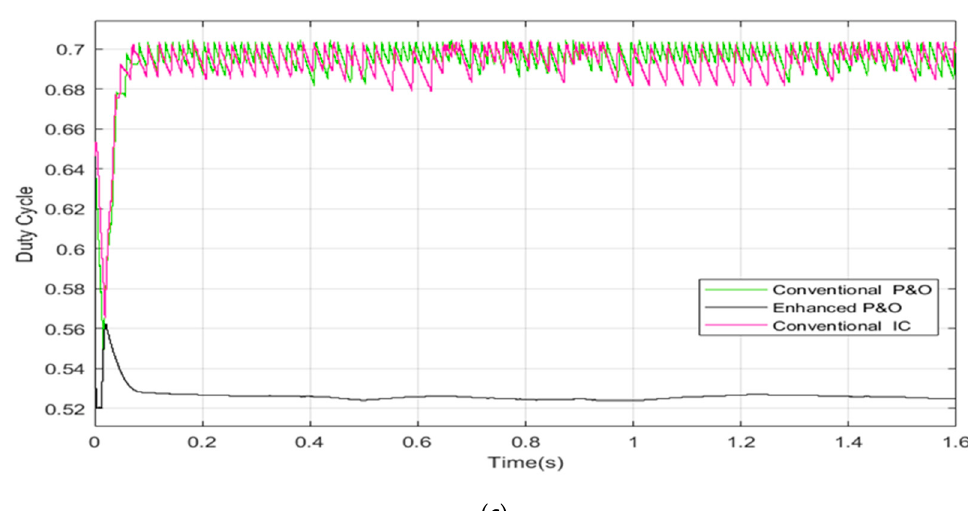
Figure 12. The simulation results of the proposed technique and the conventional P&O and IC techniques for Case Three: ( a ) Tracked output power; ( b ) Output voltage of the boost converter; ( c ) Duty cycle behaviors.